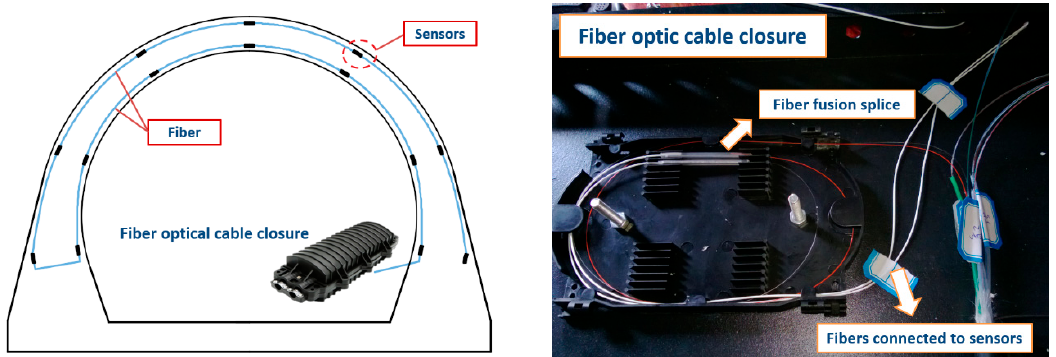
Figure 6. Fiber optic cable closure.